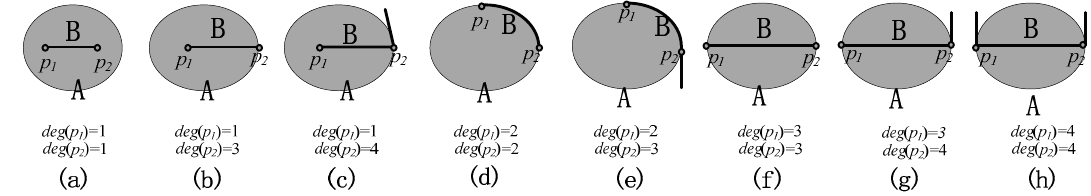
Figure 7. Intersection-line types of line/region that can be distinguished by node degree. ( a ) Case of degree-pair (1,1); ( b ) Case of degree-pair (1,3); ( c ) Case of degree-pair (1,4); ( d ) Case of degree-pair (2,2); ( e ) Case of degree-pair (2,3); ( f ) Case of degree-pair (3,3); ( g ) Case of degree-pair (3,4); ( h ) Case of degree-pair (4,4).